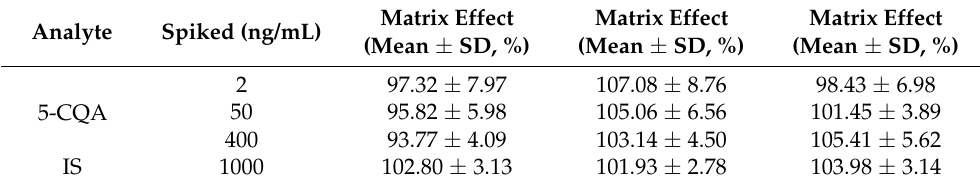
Table 2. Matrix effect of 5-CQA in the plasma, CSF, and brain homogenates of rats ( n = 5).